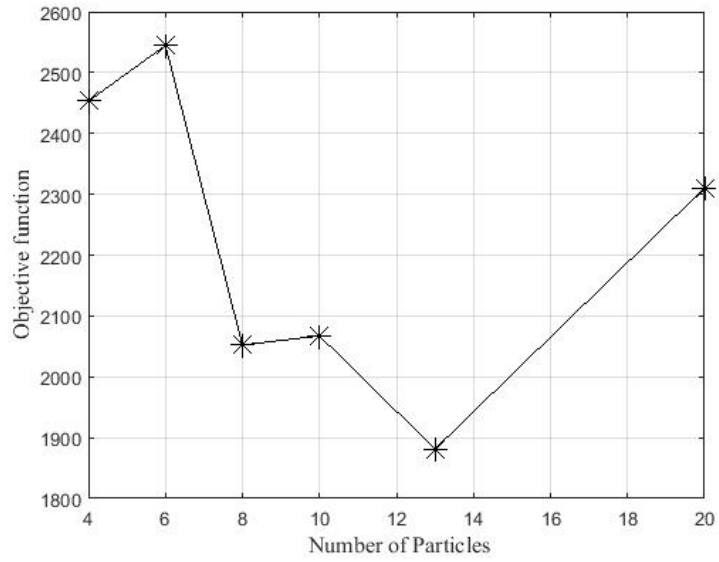
Figure 2. Objective function diagram for different numbers of particles.